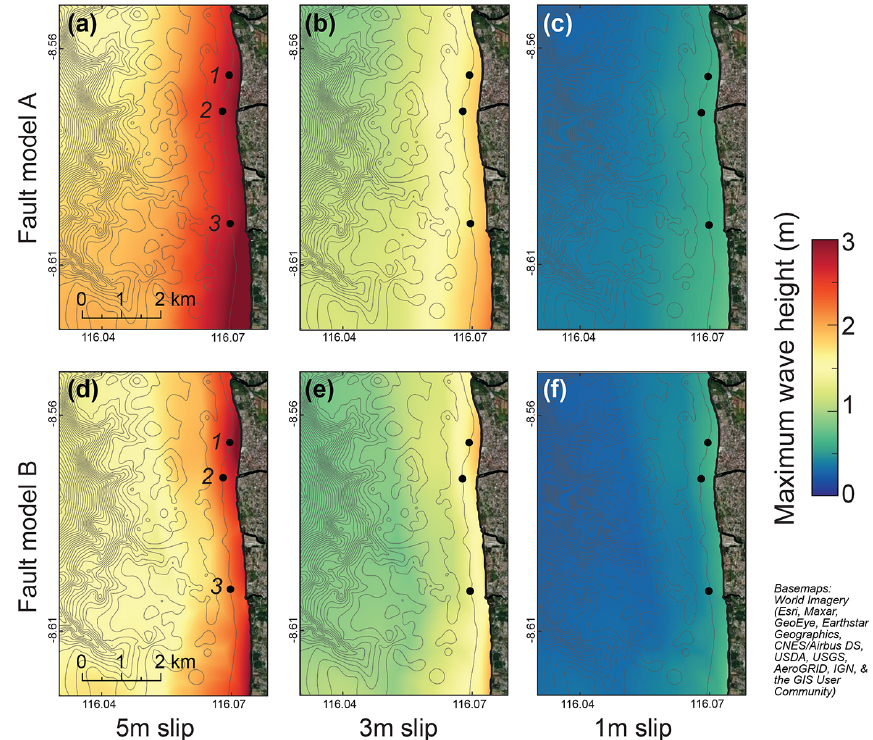
Figure 9. Maximum wave heights in Mataram, based on simulations in grid layer 2 (L2, Fig. 6), generated by slip on fault models A (a–c) and B (d–f) . Models A-5 (a) and B-5 (d) generate wave heights of ∼ 2.5 to 2.7m; models A-3 (b) and B-3 (e) generate ∼ 1.6 to 1.7m high waves; the models A-1 (c) and B-1 (f) generate ≤ 0 . 6m high waves. Basemaps – World Imagery. Dots – tide